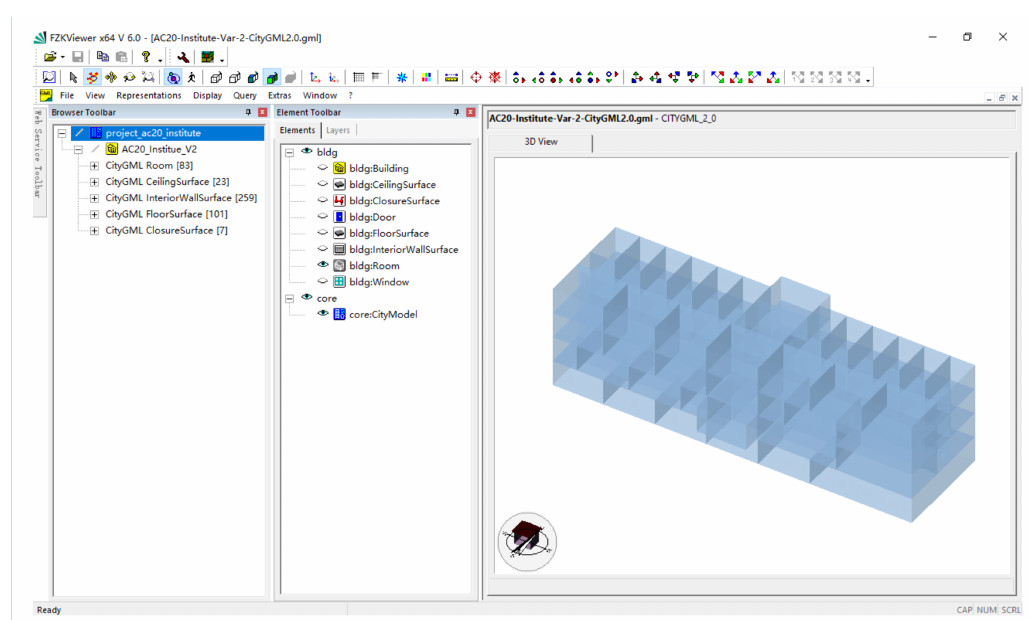
Figure 25. Indoor spaces constructed by the extracted building elements using